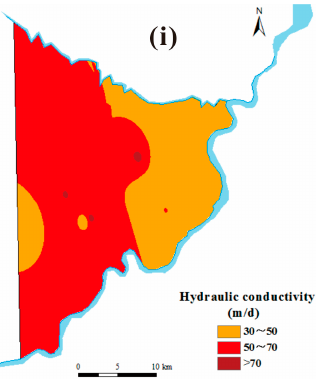
Figure 5. Spatial maps of land use types ( a , b ); depth to groundwater ( c , d ); river distance ( e ); aquifer thickness ( f ); soil media ( g ); impact of the vadose zone ( h ); and hydraulic conductivity ( i ).